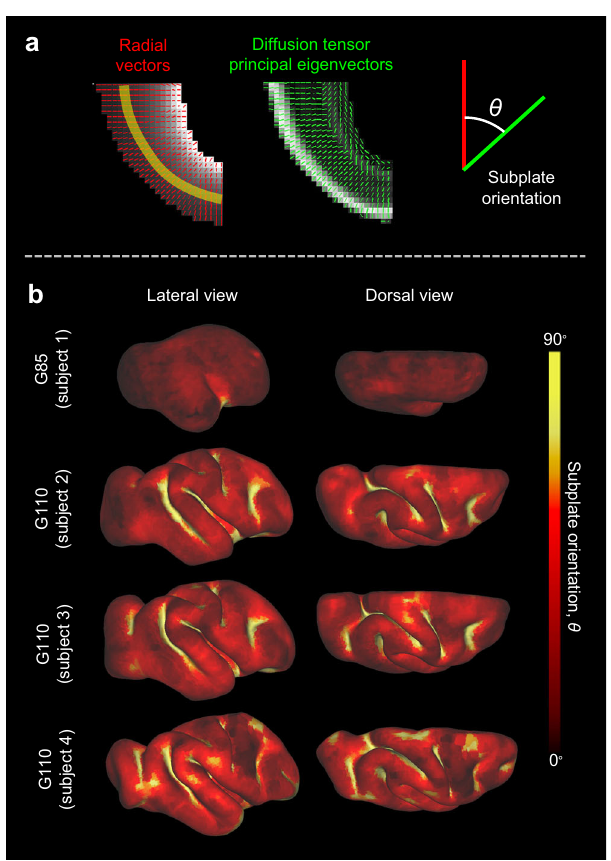
Fig. 5 Primary anisotropy orientation across subplate in developing rhesus macaque ( Macaca mulatta ). a Radial orientation vectors generated from a gradient representing distance from the cortical surface (red), and primary eigenvectors generated from DTI (green). For voxels at a set distance from the cortical surface (the super fi cial subplate, indicated by yellow strip), subplate orientation, θ , was calculated as the angle between the radial vector (red) and diffusion tensor principal eigenvector (green). b Subplate orientation, denoted by color, mapped onto cortical surface reconstructions for one G85 (top) and three individual G110 (bottom) brains. Panel a modi fi ed from Wang et al. 30 . Data are presented for the only G85 hemisphere, and for all 3 G110 hemispheres investigated in this fi ber representation enables simulation of tissue remodeling, with the goal of recapitulating the dramatic evolution of subcortical fi bers observed during the period of folding 8 – 10 . As illustrated in